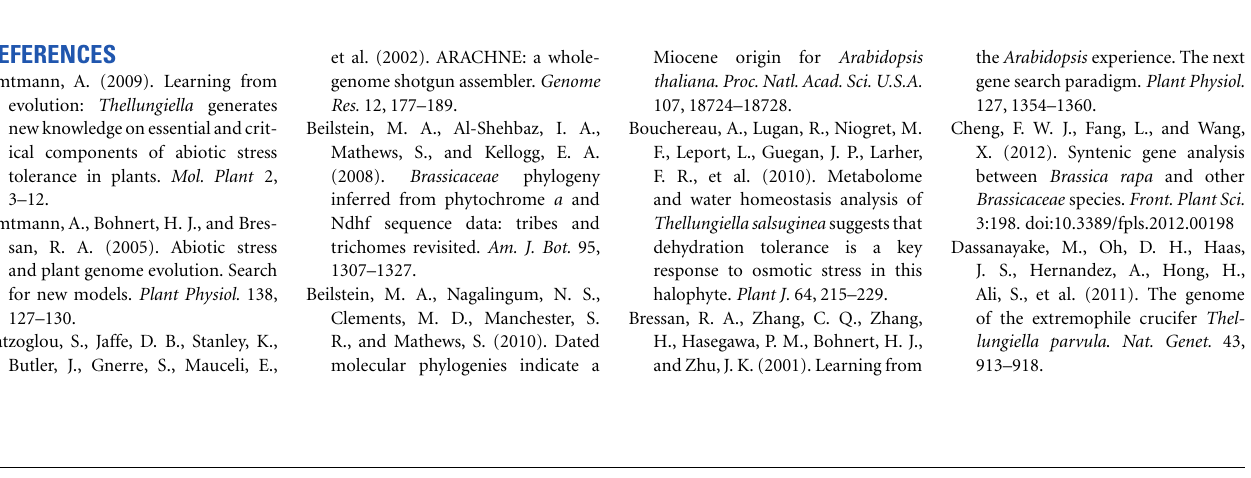
(B) Scaffold 1, 2, 5, 6, 9, 10, 13 have higher numbers of protein-coding genes while scaffold 3, 4, 7, 8, 11, and 12 have lower numbers of genes. (C) The repeat densities (percentage of the repeat-associated nucleotides) are different among different scaffolds. Figure S3 | Identification of CentO repeats in E. salsugineum . To infer the scaffold orientations, we searched for centromere-specific CentO satellite sequences that could be used to determine the centromeric ends of scaffolds. (A) A 177-bp motif (EsCentO) was found tandemly repeated over 500,000 times in E. salsugineum , sharing a similar AT-rich pattern with the 178-bp CentO repeats in A. thaliana . (B) The Es CentOs are abundant among the short scaffolds below 10kb and often located at one terminus of a large scaffold, indicating the genome assembling was mostly interrupted at the edges of core centromeres. (C) Comparison of the CentO repeat motifs in A. thaliana and E. salsugineum shows the similar size and AT-rich feature. Figure S4 | Comparison of the numbers of transcription factor families in the A. thaliana and E. salsugineum . MostTF families contain similar numbers of members between the two species. Figure S5 | (A) GO enrichment analysis shows that the two species has similar number of genes in each functional category.The GO enrichment analysis was performed by AgriGO database. (B) The genes involved in ubiquitin related protein modification pathways are over represented in E. salsugineum than in A. thaliana in category of Biological Process. (C) Over represented GO classes in Cellular Components (Left) and Molecular Function (Right). Genes in the “ubiquitin-protein ligase activity” are overrepresented in E. salsugineum